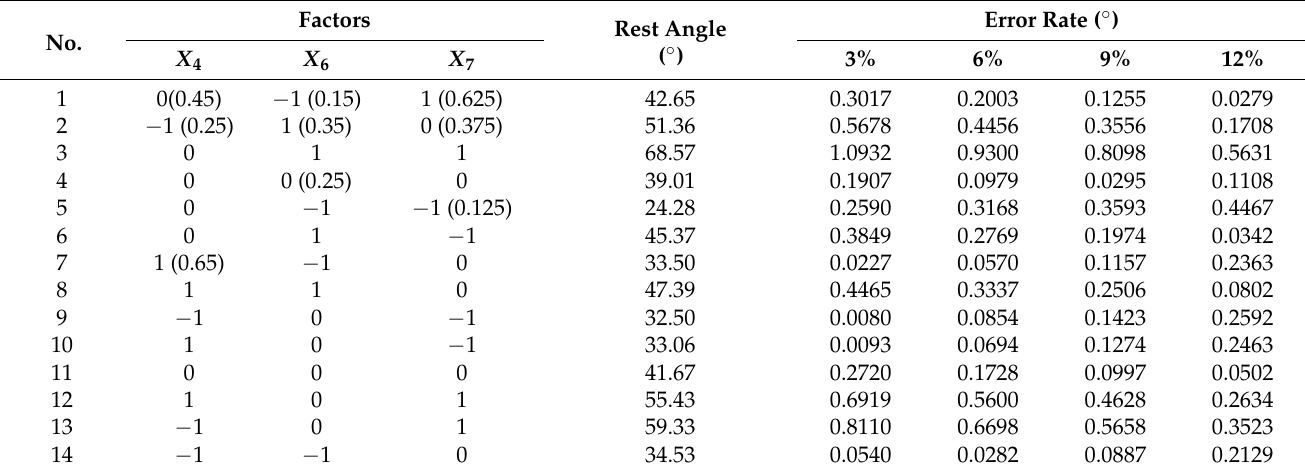
Table 9. Box–Behnken experimental design and results.